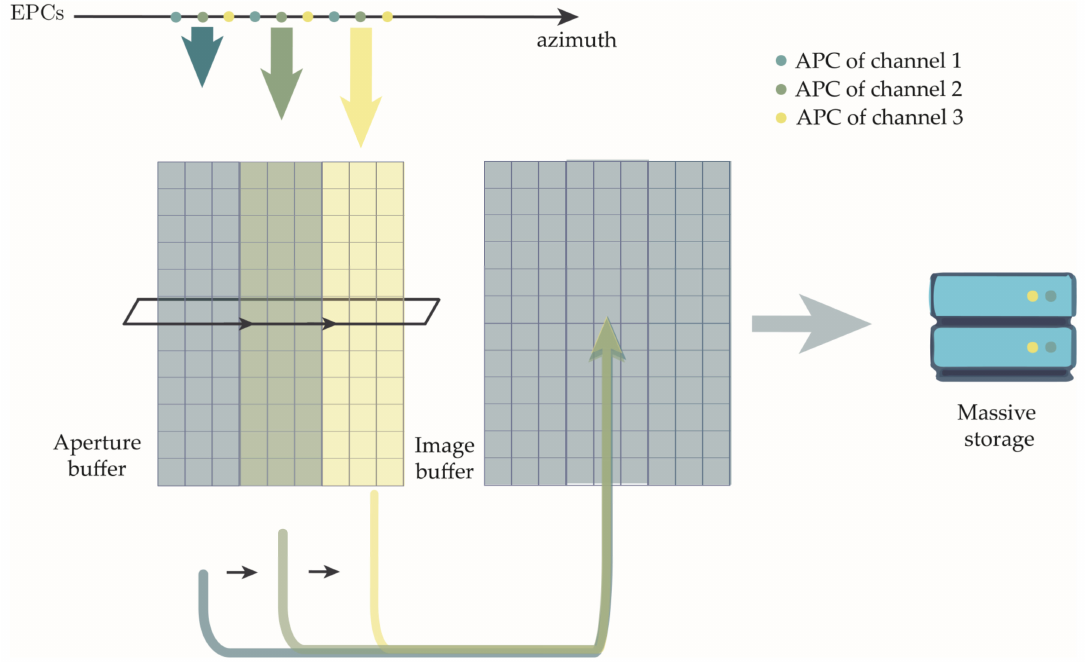
Figure 8. Three-level streaming receiving